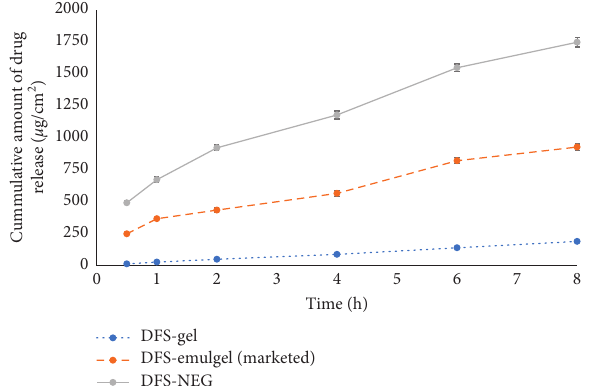
Figure 6: In vitro drug release profile of DFS from conventional gel, marketed emulgel, and nanoemulgel.